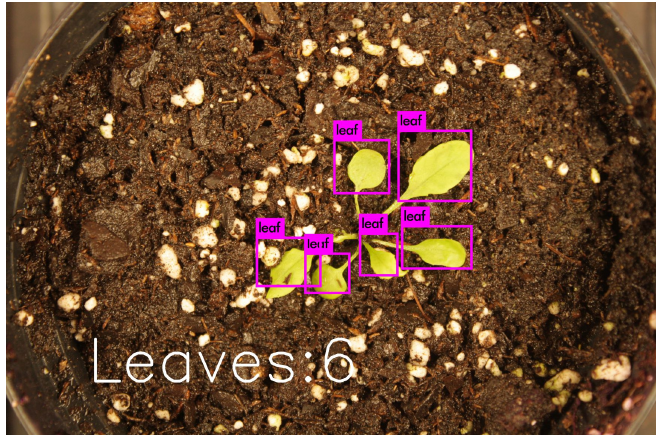
Figure 6. The leaf counting